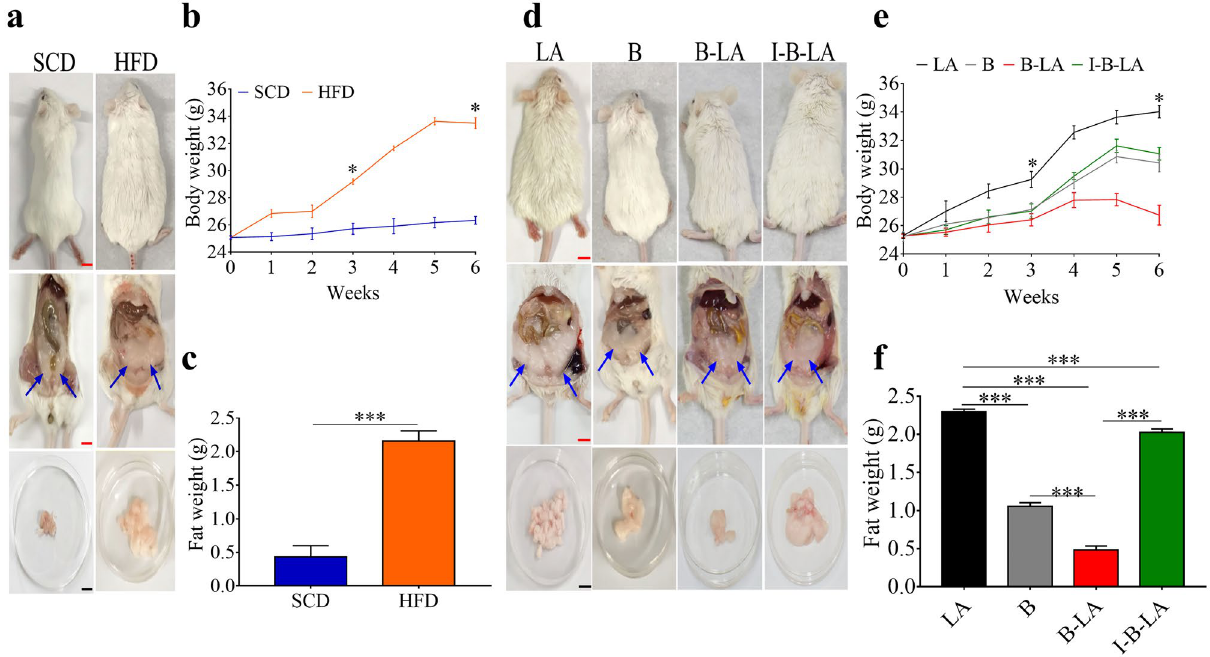
Figure 5. Essential role of electricity produced by bacteria plus linoleic acid in reduction of abdominal fat mass. ( a ) The abdominal fat (arrows) in whole body or isolated abdominal fat masses in mice fed with SCD or HFD was shown. ( b ) Change in body weight was recorded and ( c ) abdominal fat masses were dissected and weighed. HFD-fed ICR mice were administered linoleic acid (LA) alone, L. mesenteroides EH-1 bacteria alone (B), bacteria plus linoleic acid (B-LA) or TMN355-pretreated bacteria plus linoleic acid (I-B-LA) for 6 weeks. ( d ) Representative mice with abdominal fat in whole body or isolated abdominal fat masses were shown. ( e ) Change in body weight was recorded and ( f ) abdominal fat masses were dissected and weighted. Scale bars (Black) = 10 mm. Scale bars (Red) = 5 mm. Data shown represent the mean ± SD of experiment in triplicate using five mice per group. * p < 0.05. *** p < 0.001. (two-tailed t -tests by GraphPad Prism